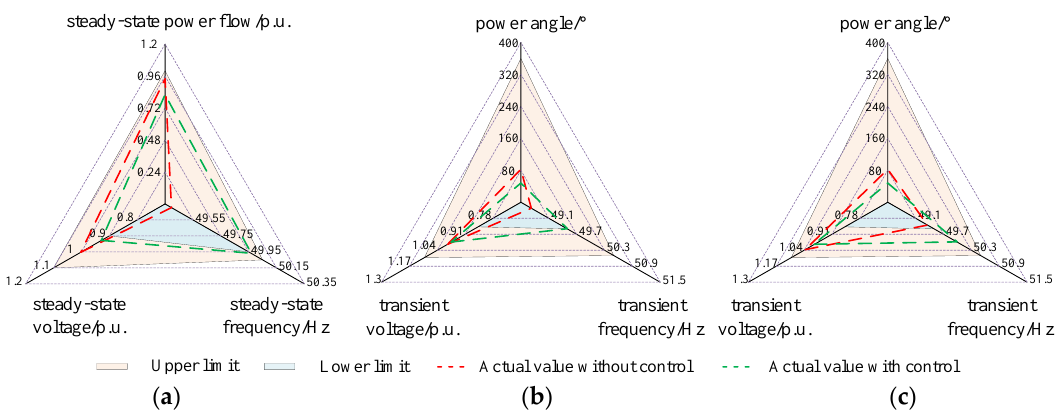
Figure 11. ( a ) Static indices; ( b ) Dynamic indices corresponding to the minimum transient frequency and voltage; ( c ) Dynamic indices corresponding to the maximum transient frequency and voltage.